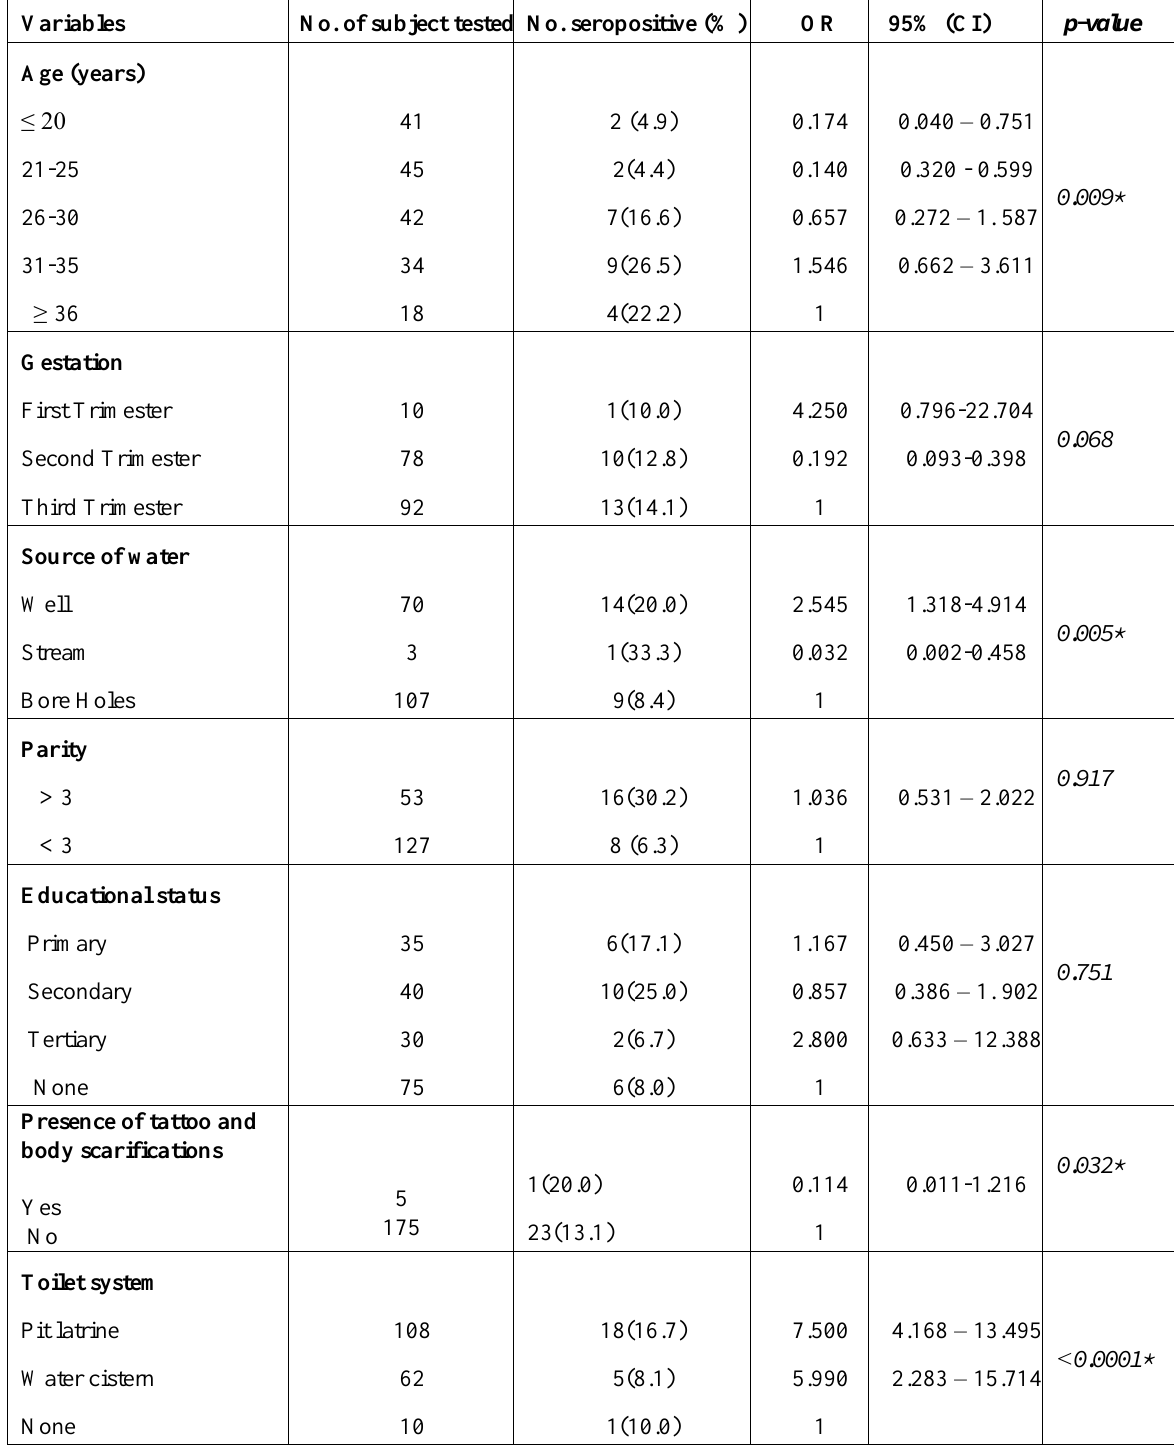
Table 1. Risk factors associated with serological evidence of recent hepatitis E virus infection.